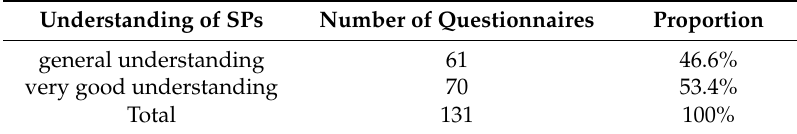
Table 4. Number of questionnaires on understanding of science parks (SPs).